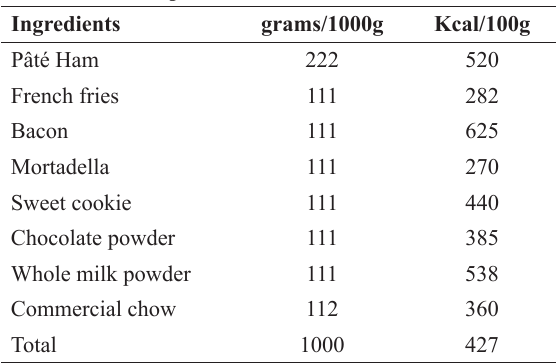
Composition of the cafeteria